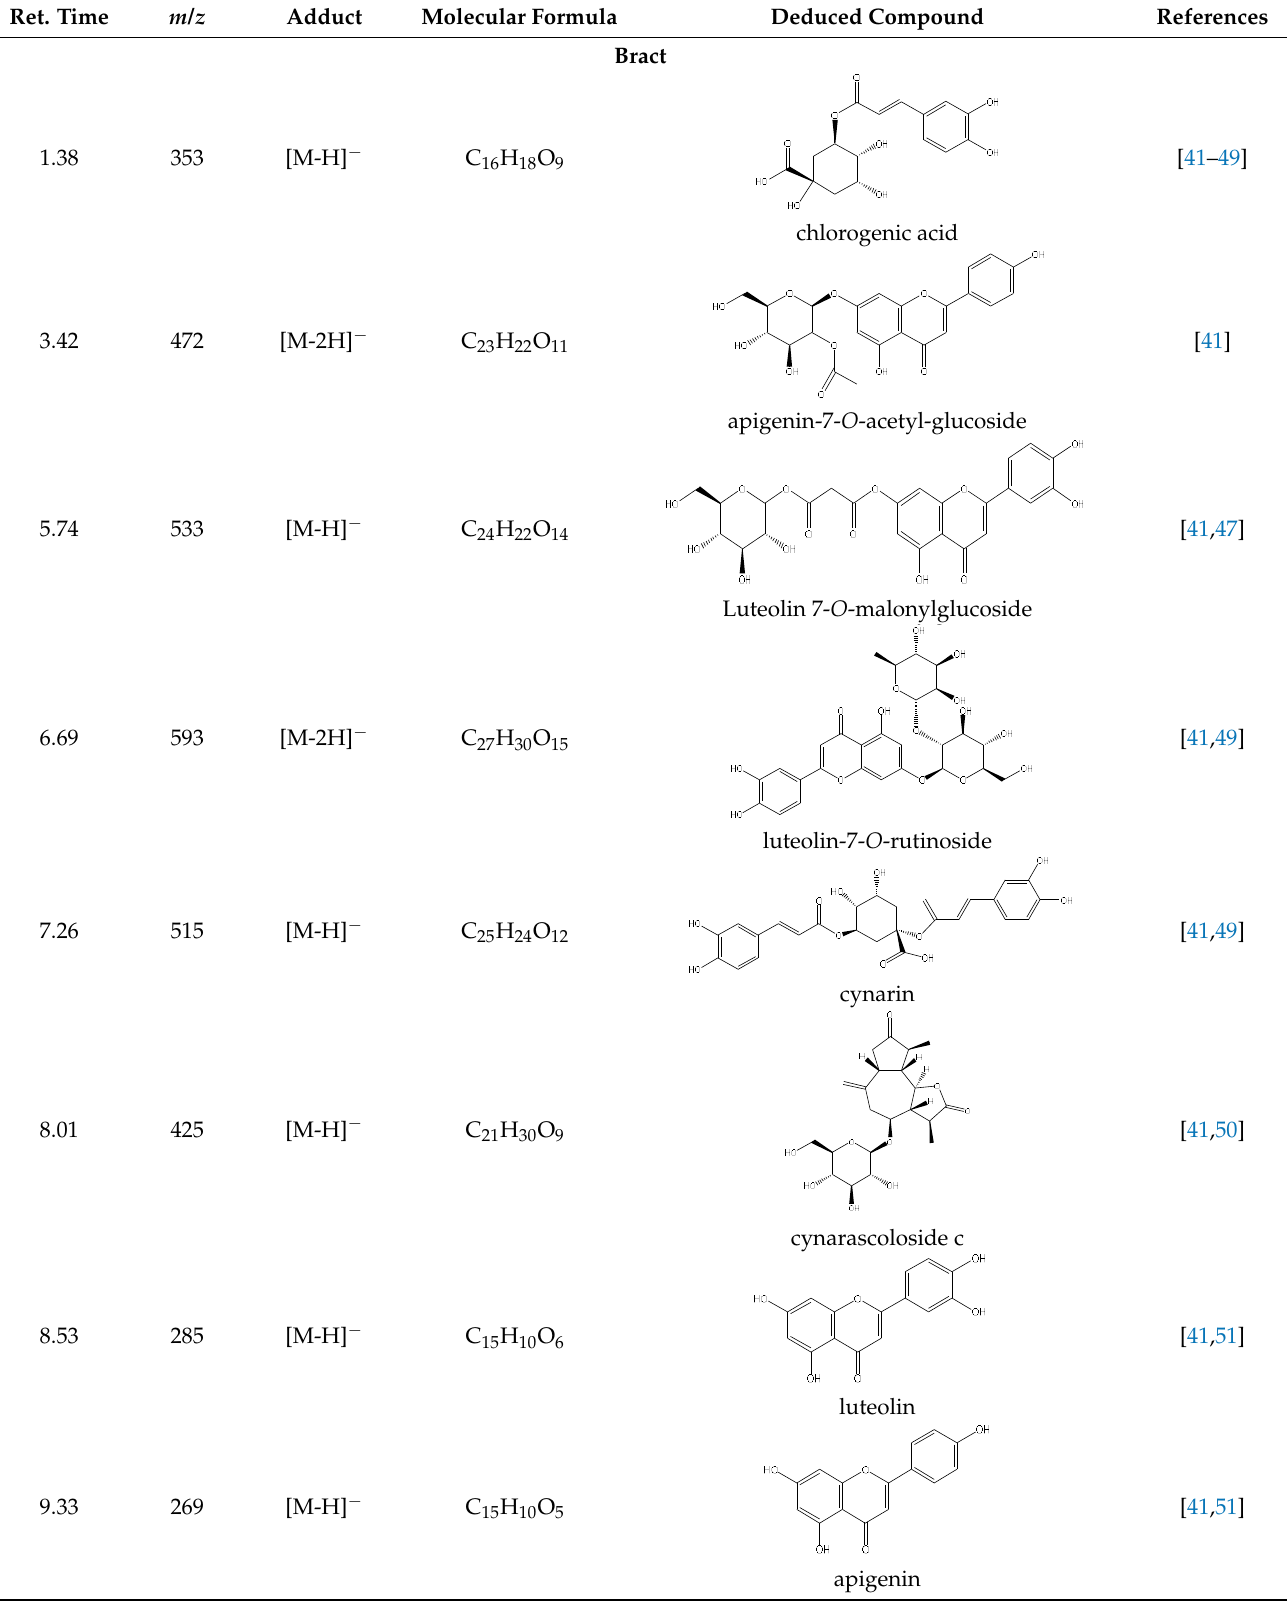
Figure 7. UPLC-ESI-MS chromatograms of crude extracts of bract ( A ), flower ( B ), and stem ( C ) of C. scolymus L. Table 4. LC-MS metabolomic analysis of methanolic crude extracts of bract, flower, and stem of C. scolymus L.